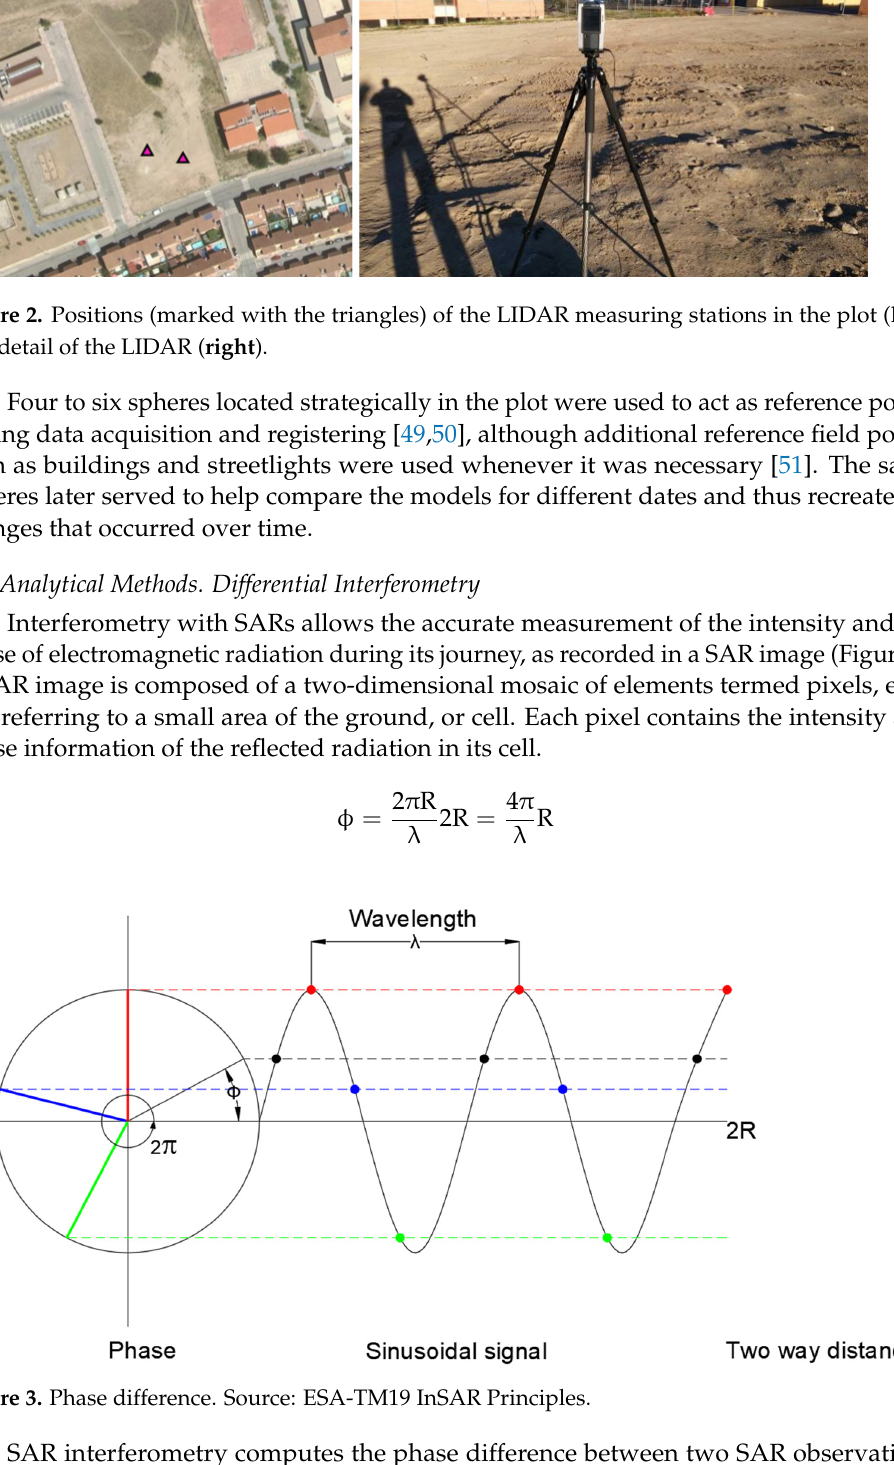
Figure 3. Phase difference. Source: ESA-TM19 InSAR Principles.